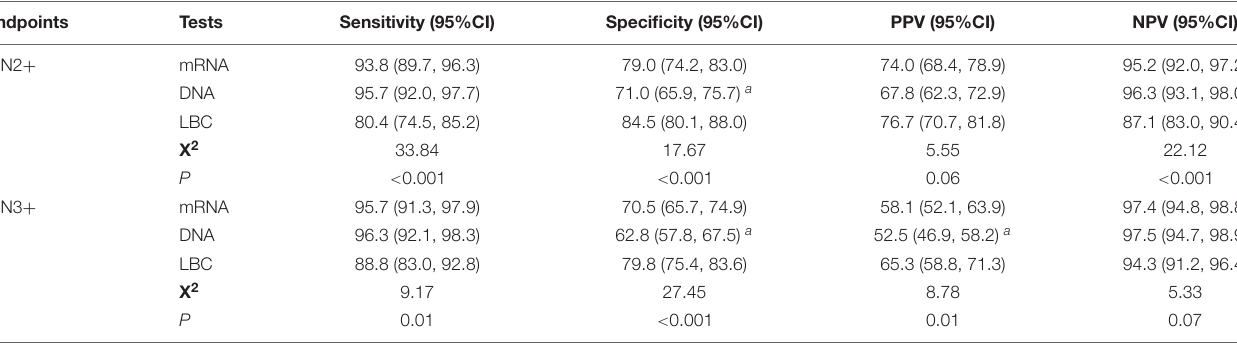
TABLE 3 | The clinical performance for tests to detect CIN2 + and CIN3 + lesions